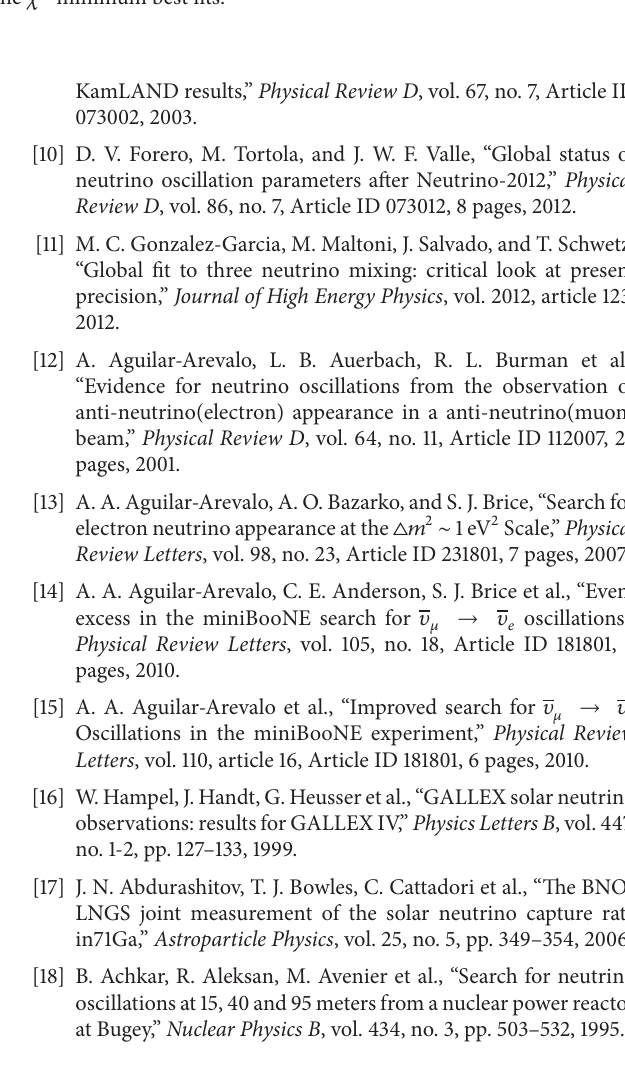
Figure 7: Comparison of rate-only analysis and spectral shape analysis: in both (A) and (B), the regions allowed by rate-only analysis are overlapped in 1𝜎 range of shape analysis, while they do not include the 𝜒 2 -minimum best